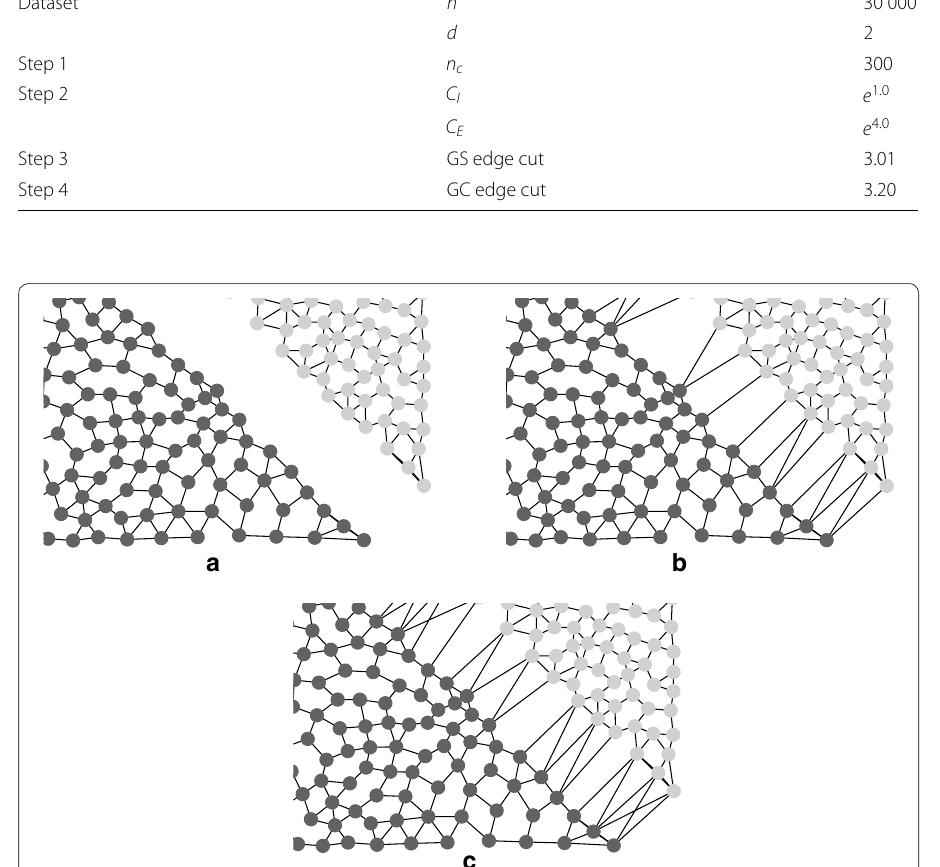
Fig. 4 Exclusive neighbor search. Number of ENS iterations are 0, 2, and 4 in a – c , respectively. Zoomed view of dataset in Fig.